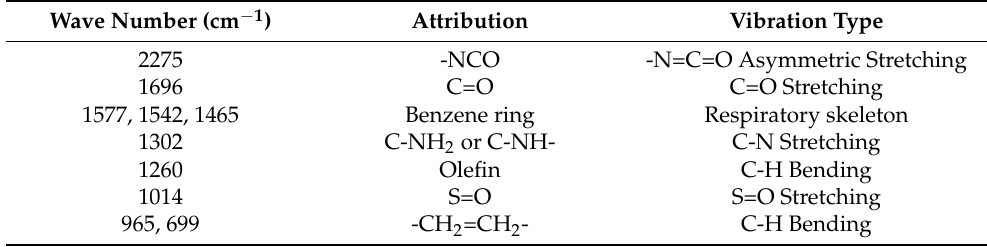
Figure 2. Effect of different rejuvenators on the molecular structure of aSBSmB. Table 2. Attributes of the main characteristic peaks.